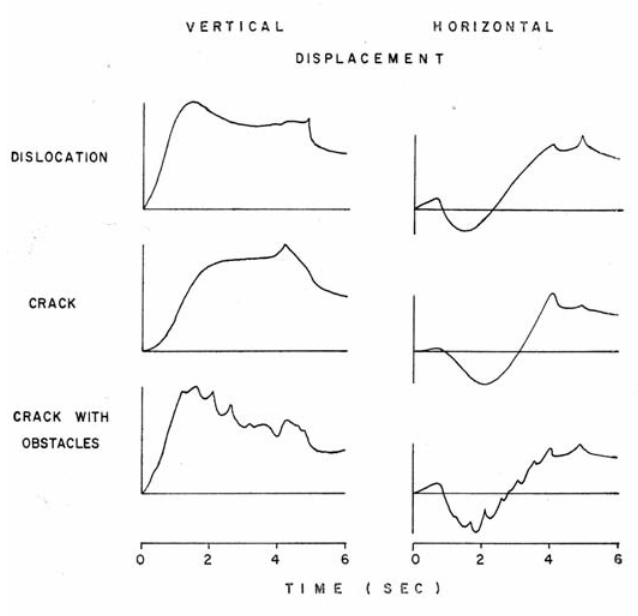
Figure 11. Synthetic surface motion at Pacoima Dam due to slip on the upper segment of the fault. The top trace corresponds to the case of uniform step-dislocation, the second to the case of a unilateral single crack nucleating at the bottom of the upper fault segment, and the bottom trace to the case of multiple cracks with seven unbroken